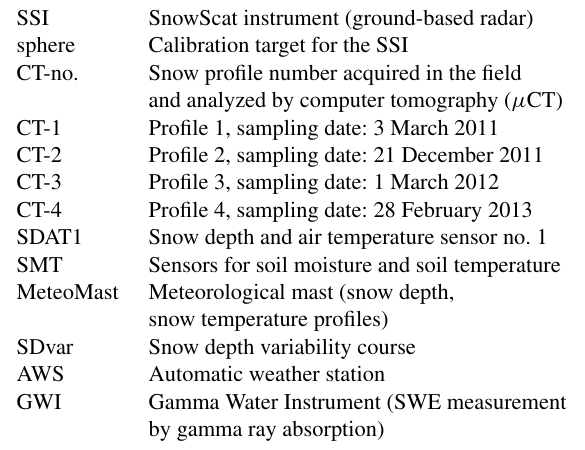
Table 1. Abbreviations for different sensors and